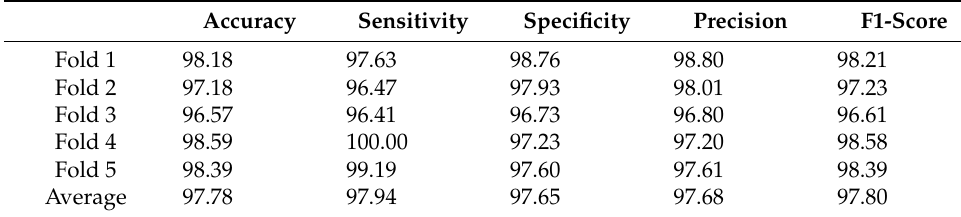
Table 4. Results of the CGENet based on 5-fold CV (unit: %).